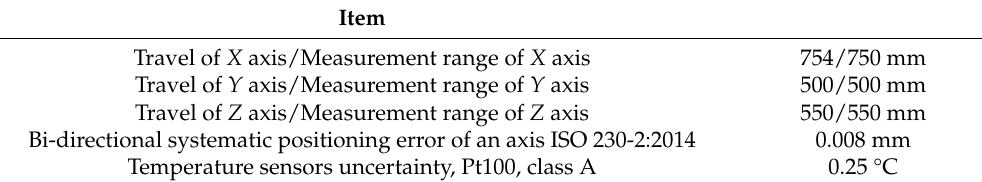
Figure 1. Demonstrator MCV 754 QUICK. Table 1. CNC machine tools technical parameters.